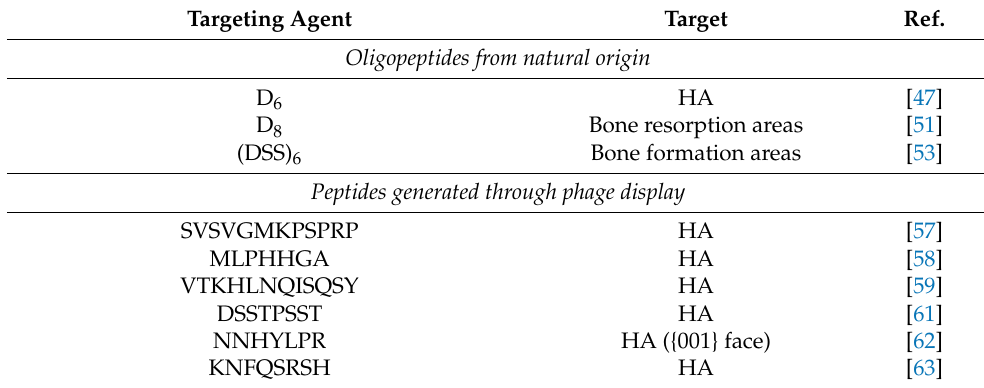
Table 1. Seminal papers reporting relevant bone-targeting agents for the first